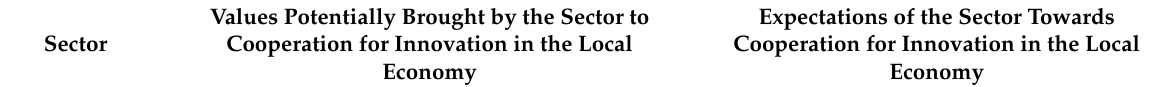
Table 2. Value exchange in the process of cooperation between HEIs and local economy actors.